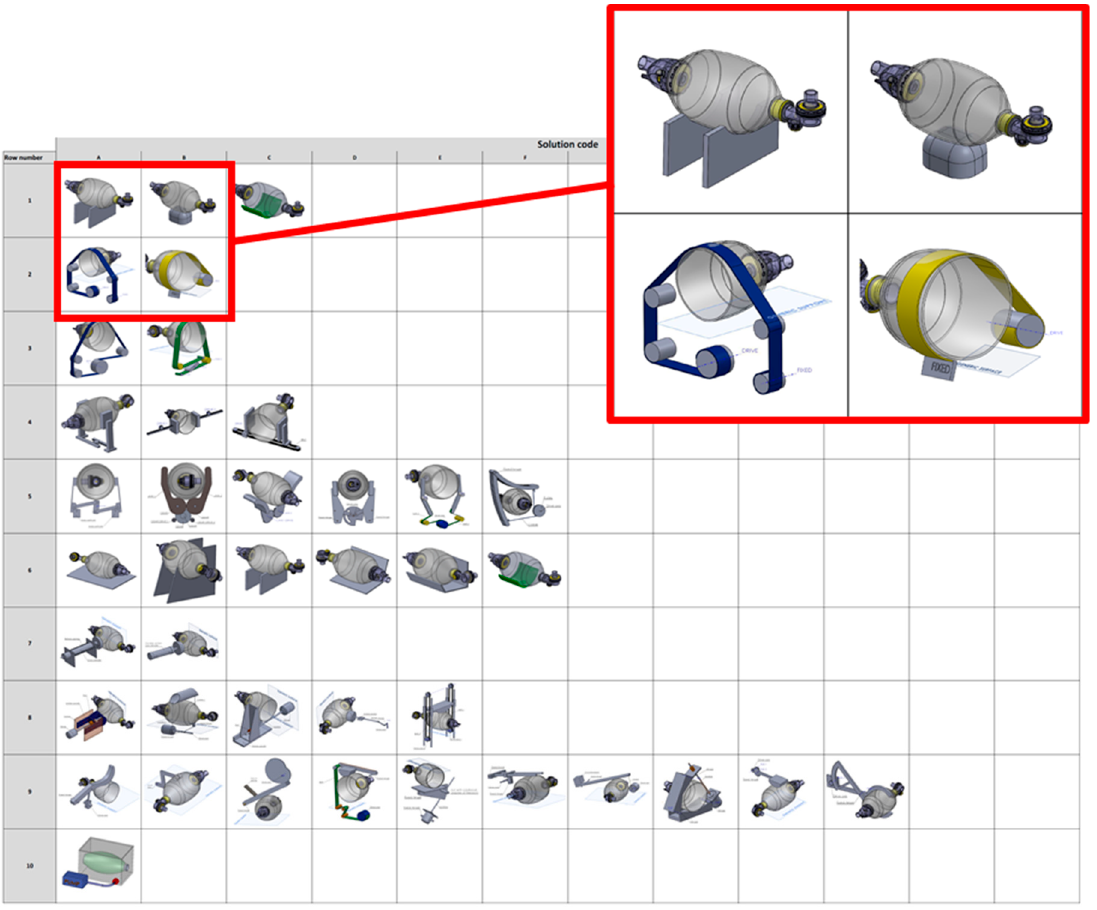
Figure 7. Overview and detailed excerpt of the chart obtained from the PSN shown in Figure 6. Please see the freely available dataset [71] for a full-scale view.